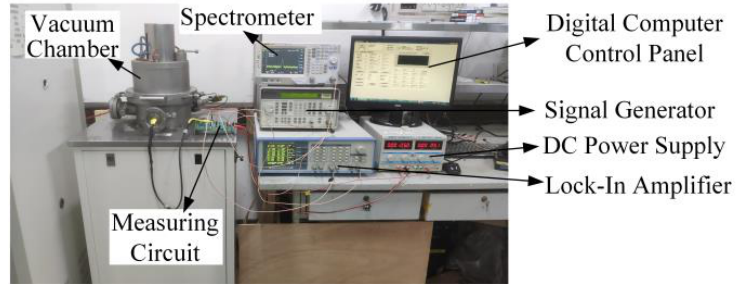
Figure 3. Photo of closed-loop test equipment.